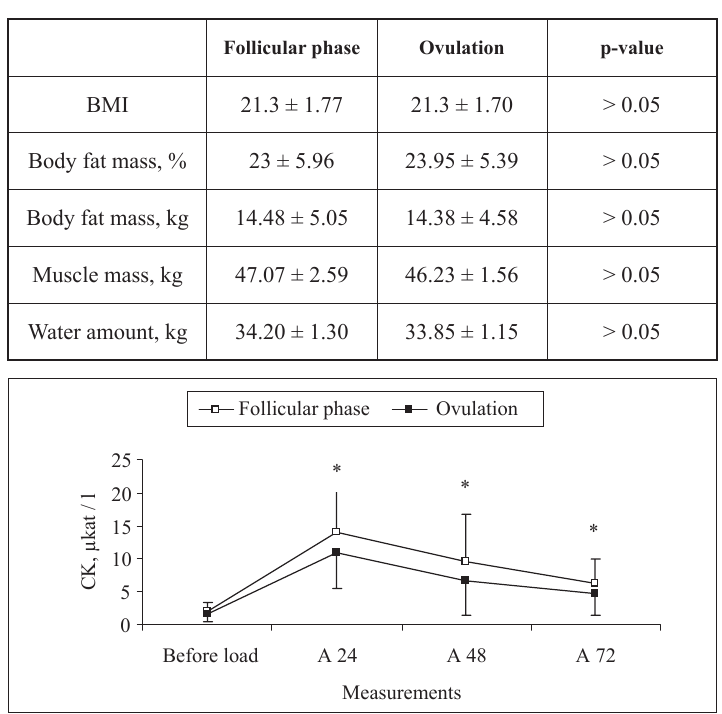
Table. Body composition values in the ovula- tion and the follicular phase